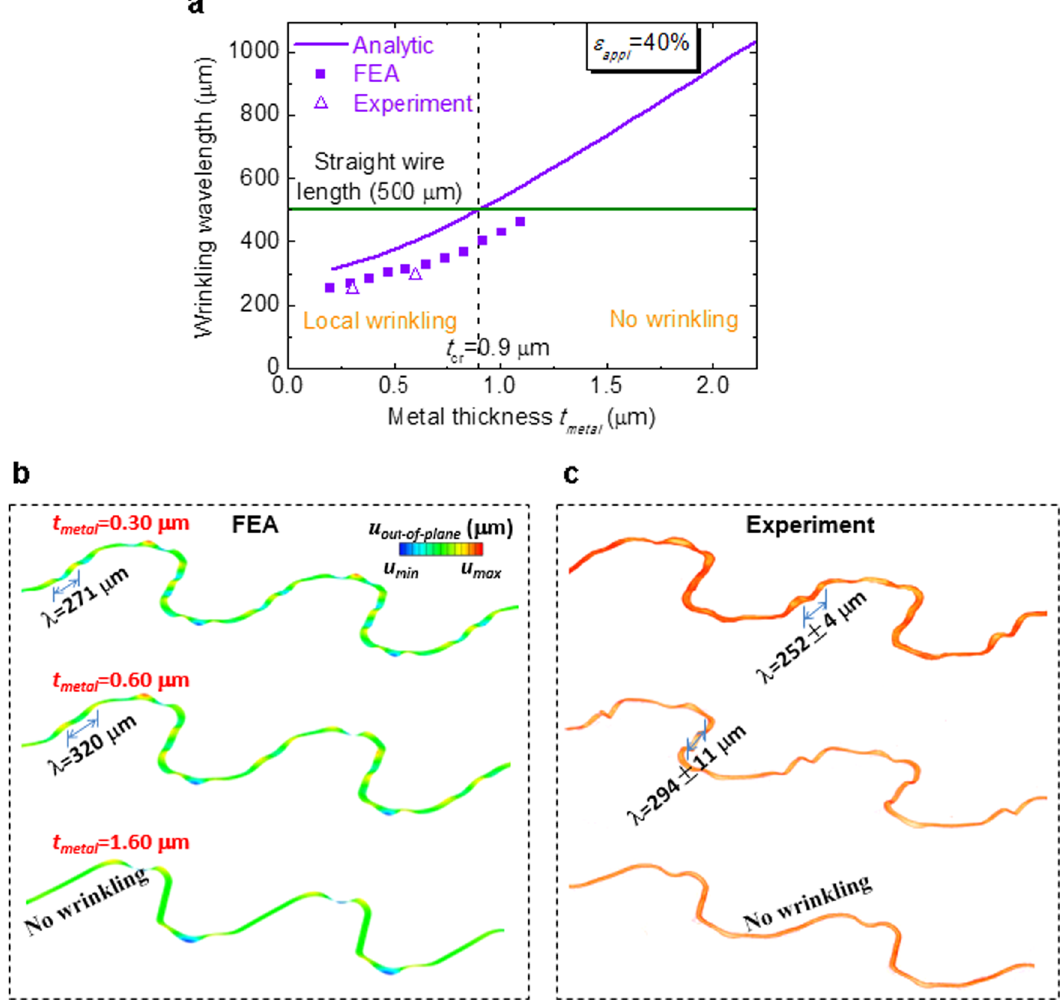
Fig. 4 a Wrinkling wavelength vs. metal thickness of the serpentine; b numerical results and c 3D XCT scanning images of the deformed con fi gurations for the three buckling modes. (Reprinted with permission from ref.